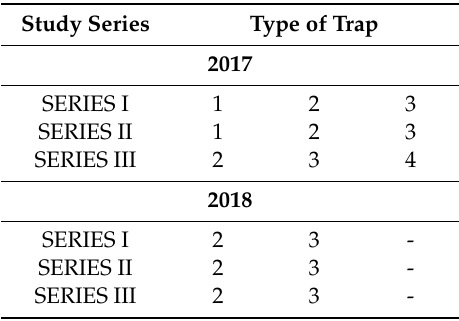
Table 2. Comparison of used traps in the